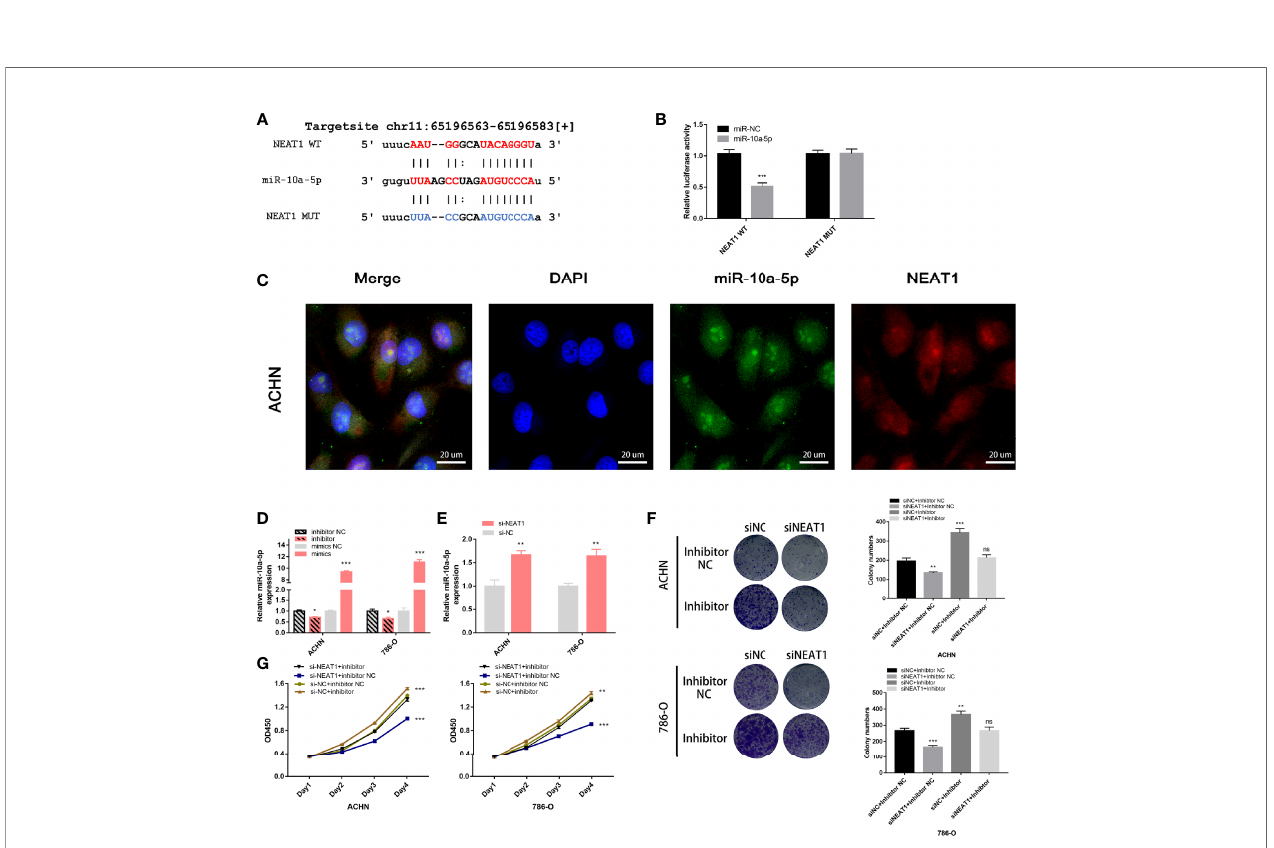
FIGURE 8 | NEAT1 serves as sponge for miR ‑ 10a-5p in kidney cancer cells. (A) Prediction the target sequence of NEAT1 bonding to miR-10a-5p by starBase; (B) Dual luciferase reporter gene assays verify the direct binding of miR-10a-5p to NEAT1 target sequence; (C) FISH assays con fi rm that NEAT1 co-localizes with miR-10a-5p in the cytoplasm of kidney cancer cells; (D) Validation the ef fi ciency of miR-10a-5p mimic and inhibitor by RT-qPCR; (E) Knockdown of NEAT1 enhances the expression of miR-10a-5p; (F, G) miR-10a-5p inhibitor reverses the inhibition of cell proliferation caused by siNEAT1. ns, not signi fi cant, p ≥ 0.05; *p < 0.05; **p < 0.01; ***p <